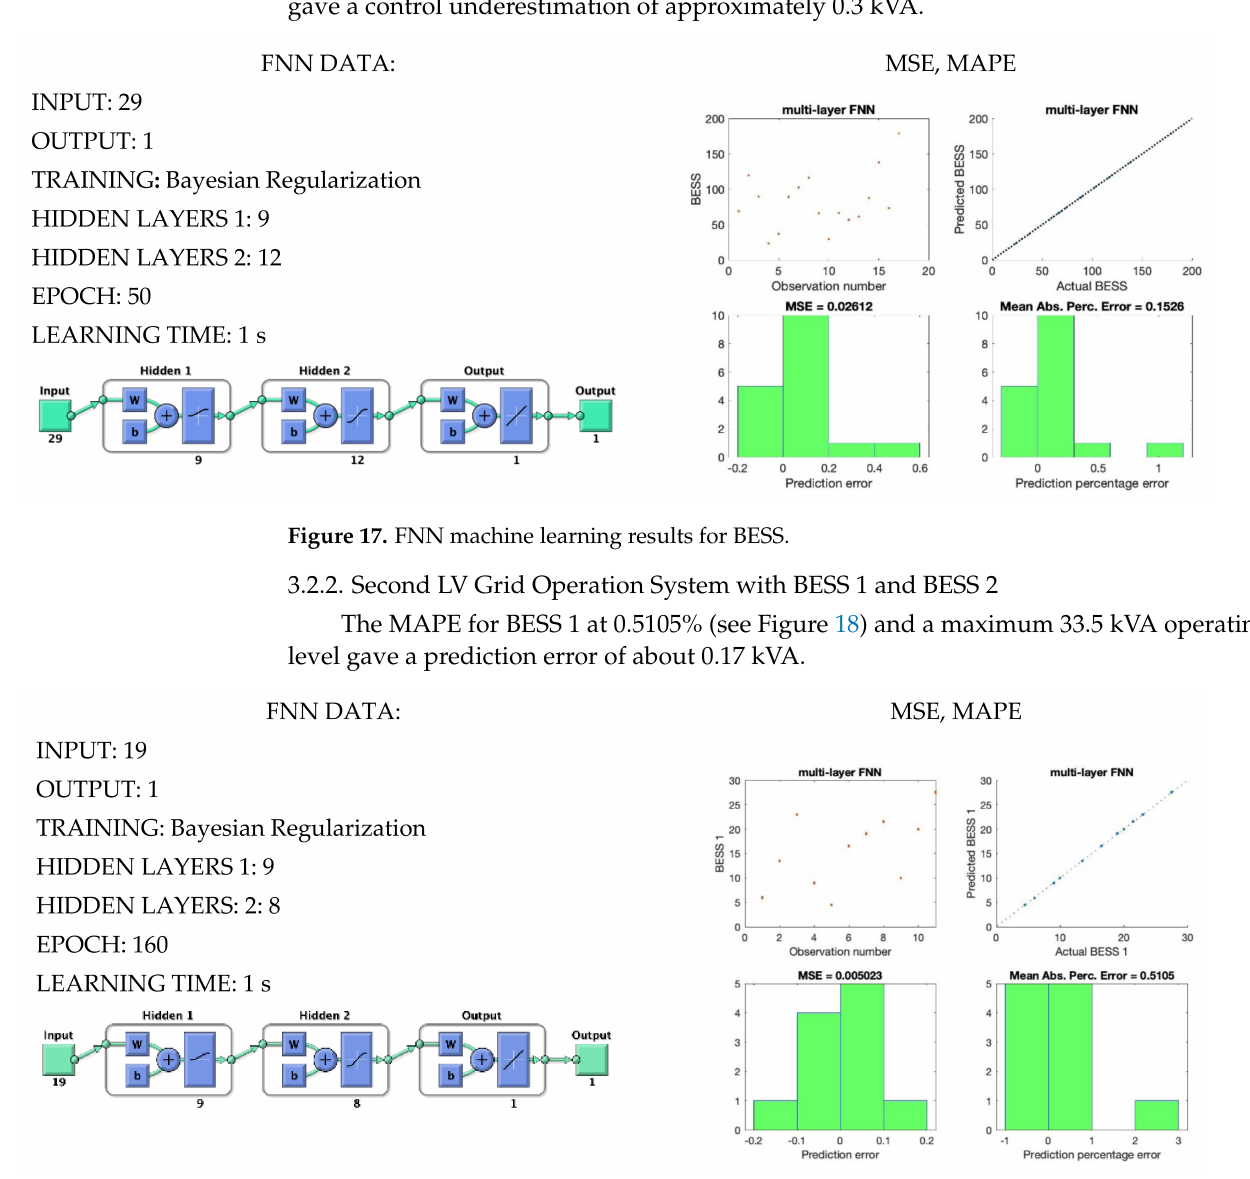
Figure 18. FNN machine learning results for BESS